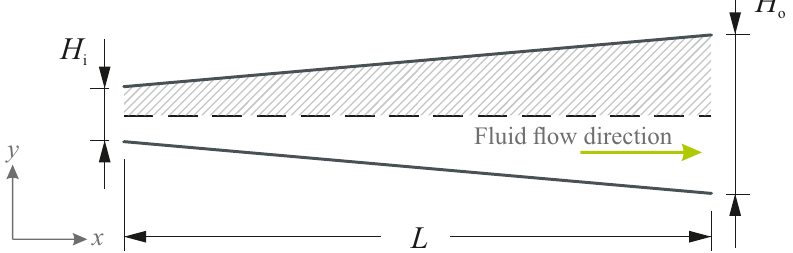
Figure 1. Schematic of the divergent microchannel considered in the present study. The hatched region was considered for calculations.